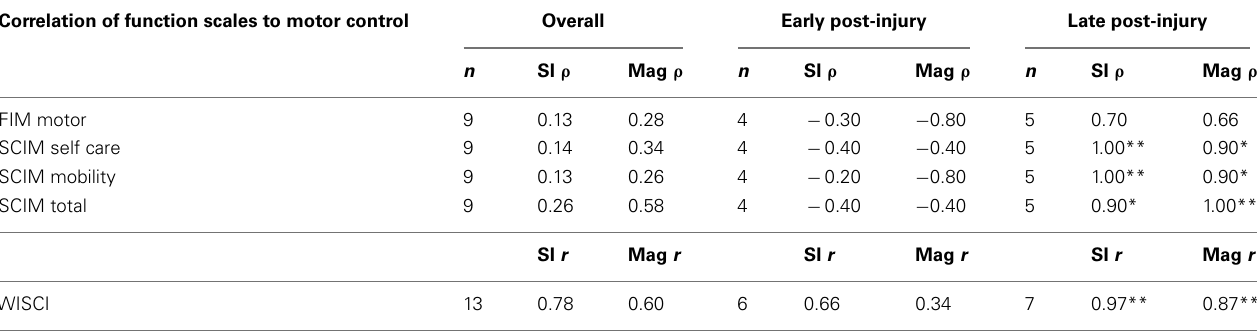
Table 4 | Correlation values comparing clinical scale scores to neurophysiological sEMG-based magnitude (Mag) and similarity index (SI) overall, early (within 19days) and late (after 48days) post-injury. Correlation of function scales to motor control